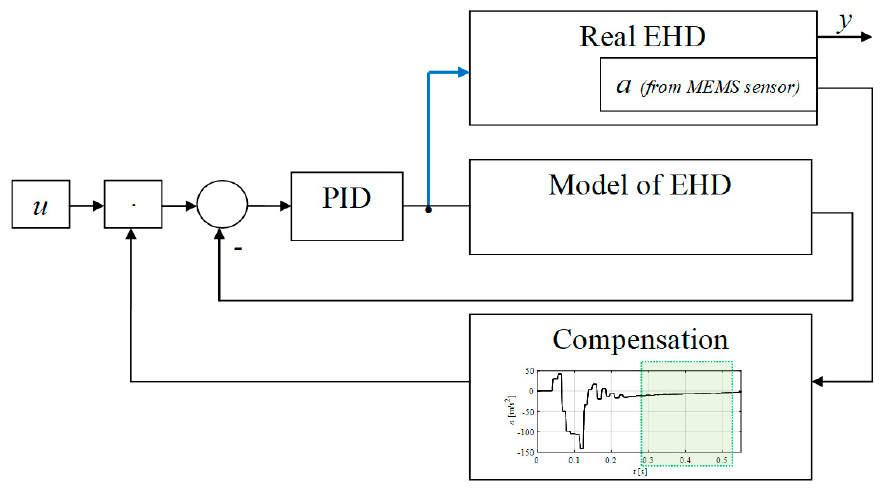
Figure 2. Control system schematic (EHD—electrohydraulic drive).